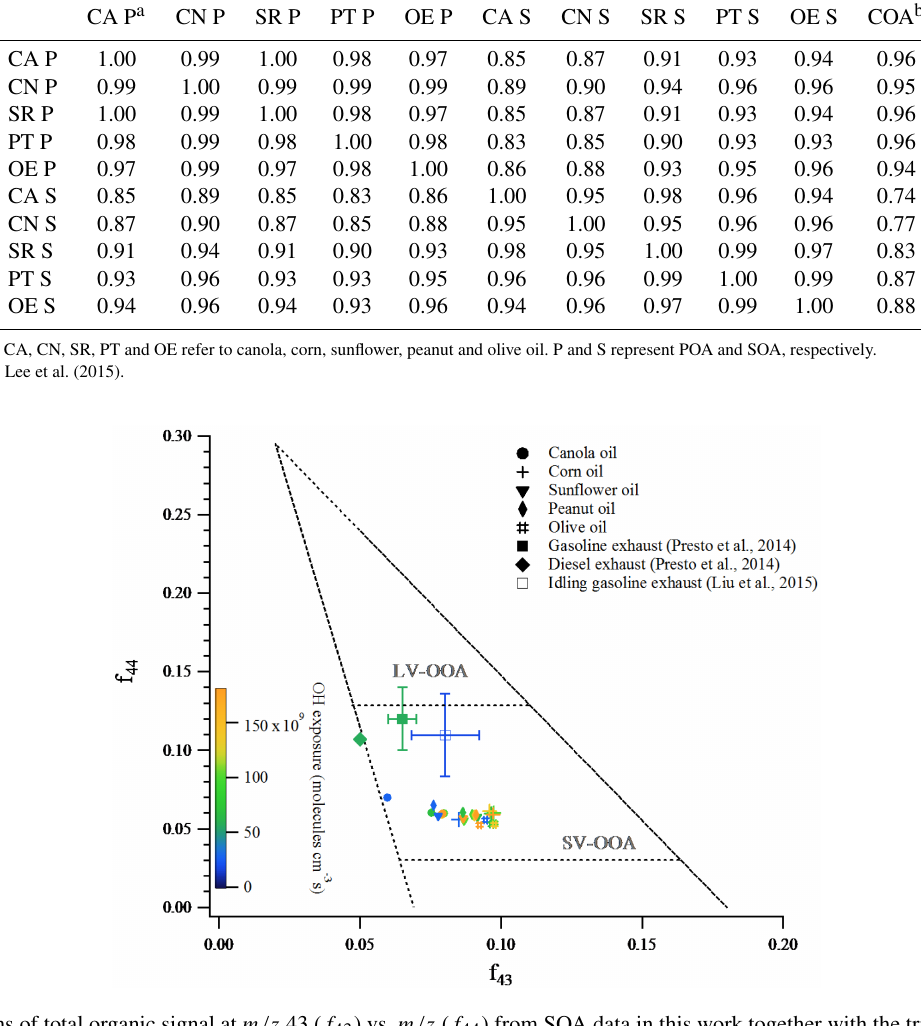
Figure 6. Fractions of total organic signal at m/z 43 ( f 43 ) vs. m/z ( f 44 ) from SOA data in this work together with the triangle plot of Ng et al. (2010). SOA data from gasoline (Presto et al., 2014; Liu et al., 2015) and diesel (Presto et al., 2014) vehicle exhaust measured in smog chamber studies are shown. Data from this work and the literature are colored according to OH exposure. Ambient SV-OOA and LV-OOA regions are adapted from Ng et al.